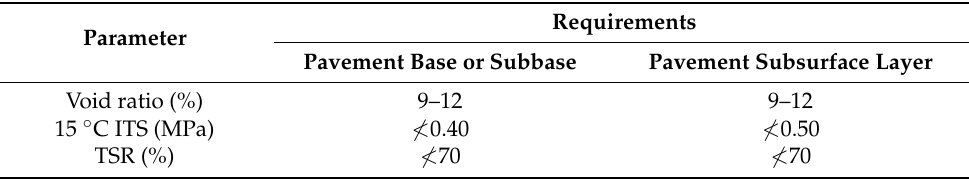
Table 7. Technical requirements for CRAM design